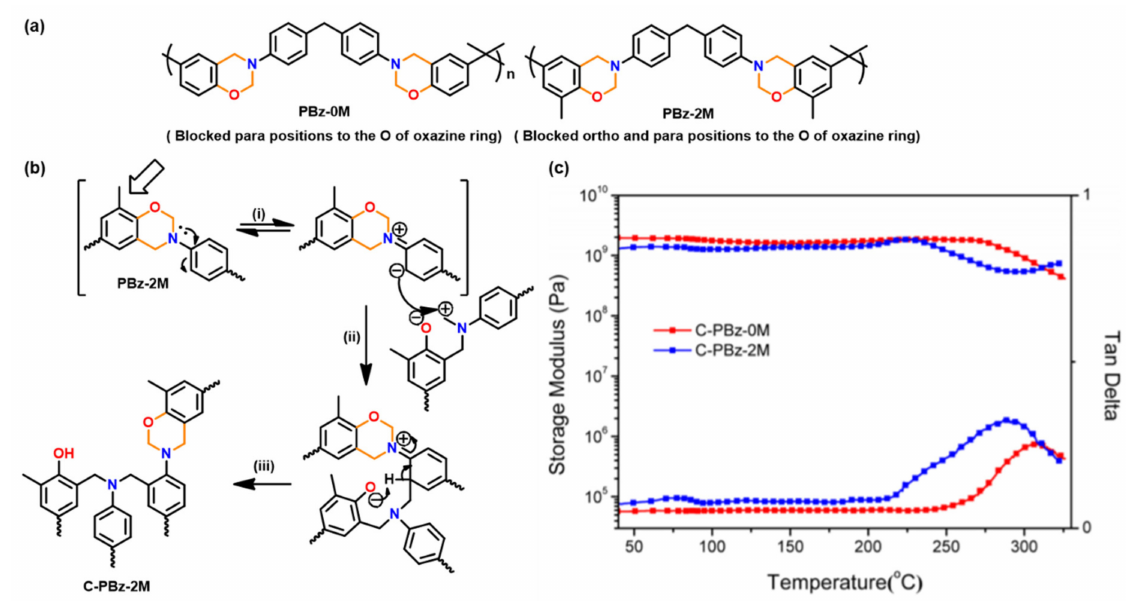
Figure 22. ( a ) Mode of polymerization of main chain type o - ad p -blocked benzoxazine polymer. ( b ) Proposed ROP Mechanism for PBz-2M [226]. ( c ) DMA thermograms of C-PBz-0M and C-PBz-2M [226]. Copyright 2015. Reproduced with permission from American Chemical Society.